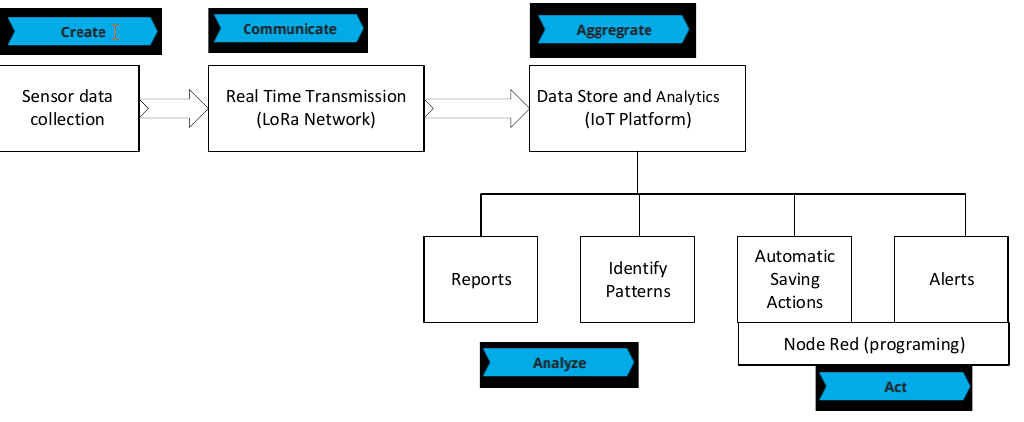
Figure 3. The main approach of the Smart Campus initiative.